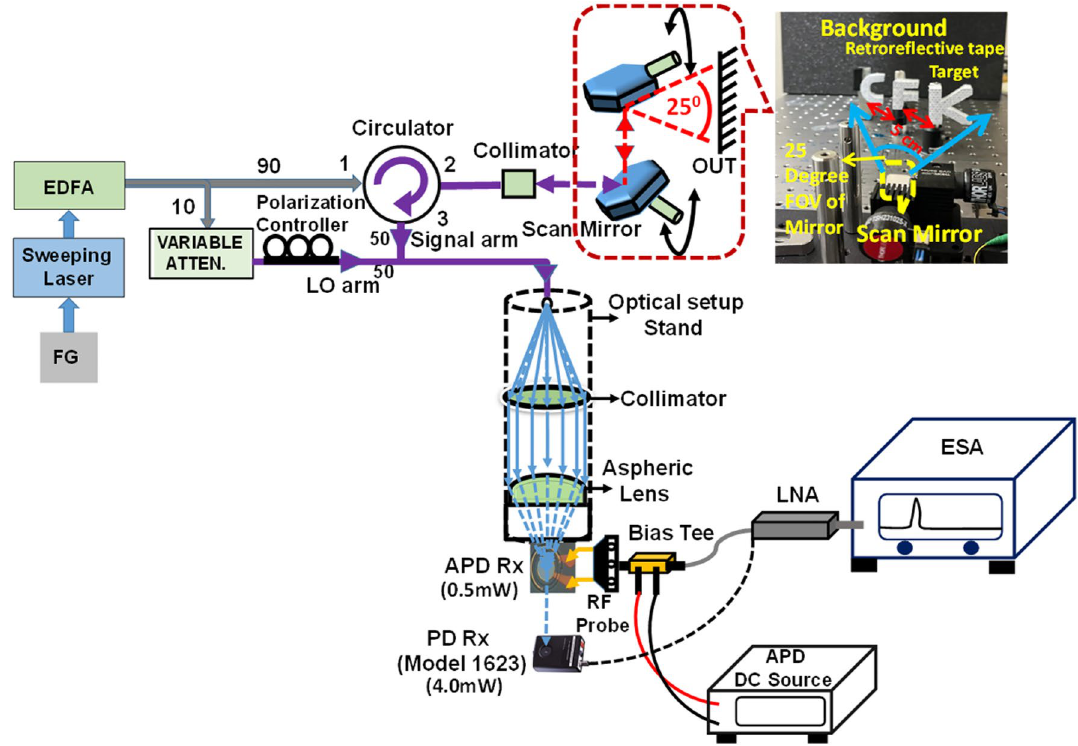
Figure 10. Schematic representation of the demonstrated FMCW LiDAR system with APD Rx (Device A and Device B) and p-i-n PD